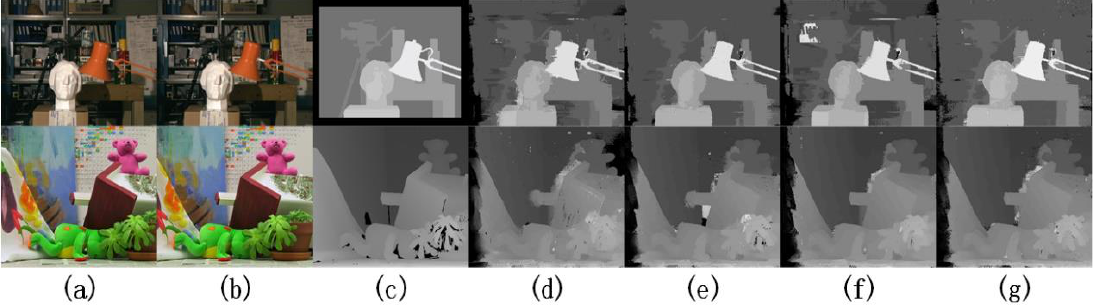
Figure 3. Comparison of different matching cost for Tsukuba and Teddy. ( a ) Left image; ( b ) right image; ( c ) ground truth map; ( d ) absolute difference of image channels; ( e ) absolute difference of image gradients; ( f ) traditional census transform-based matching cost; ( g ) proposed combined matching cost.